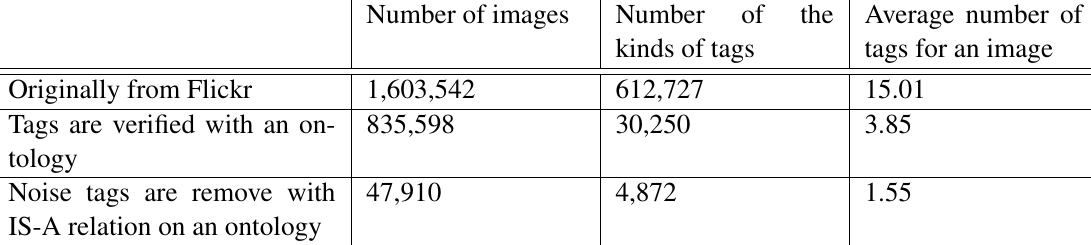
Table 2. Transition of statistical information about tags for each